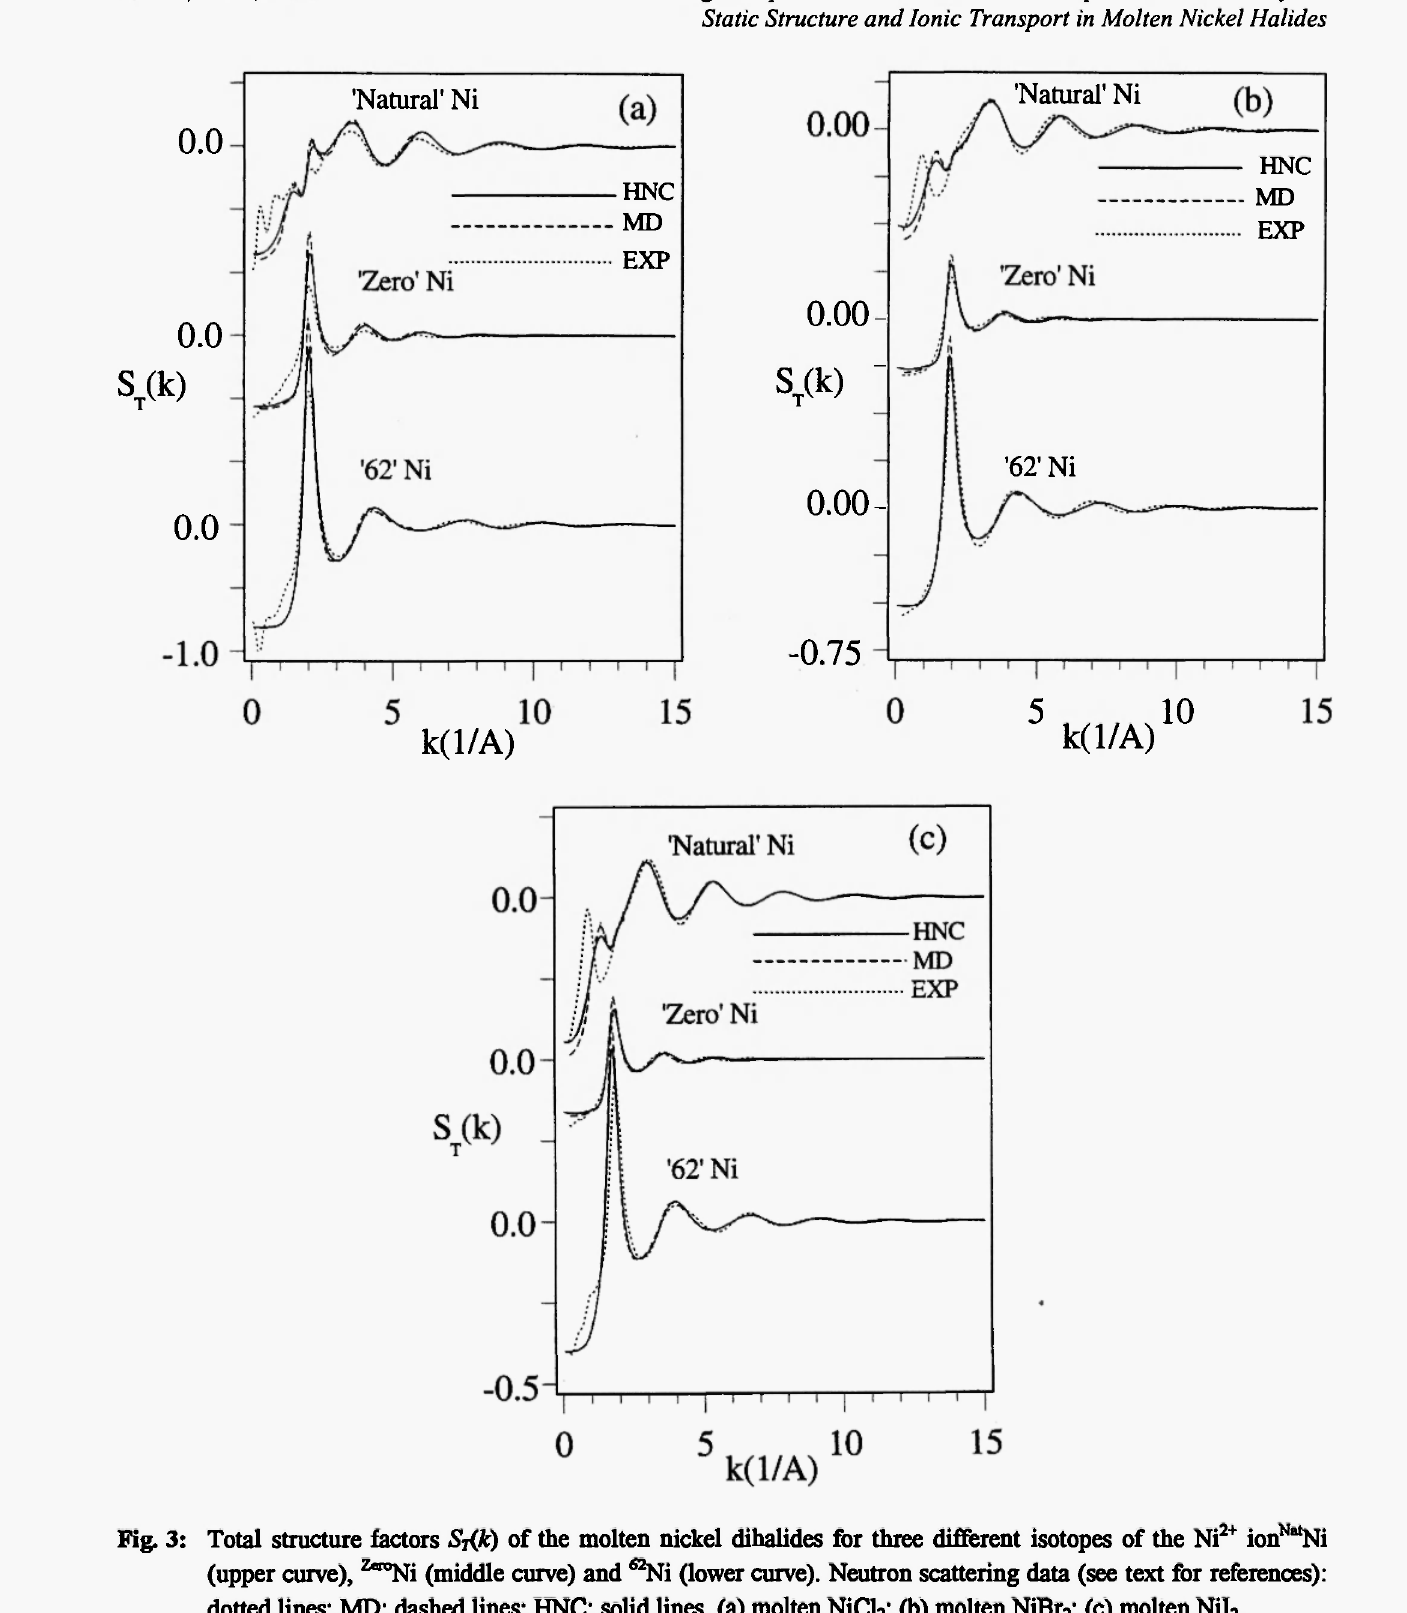
; (b) molten NiBr ; (c) molten Nil 2 2 2